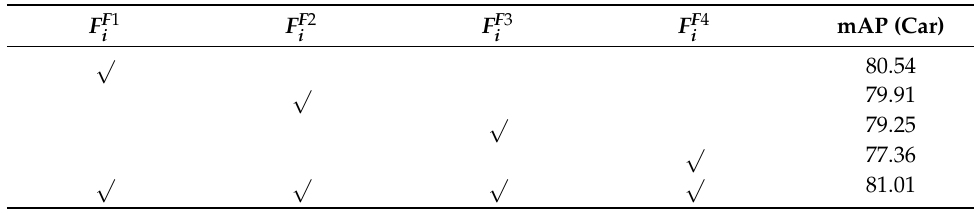
Table 6. Effects of different feature components.